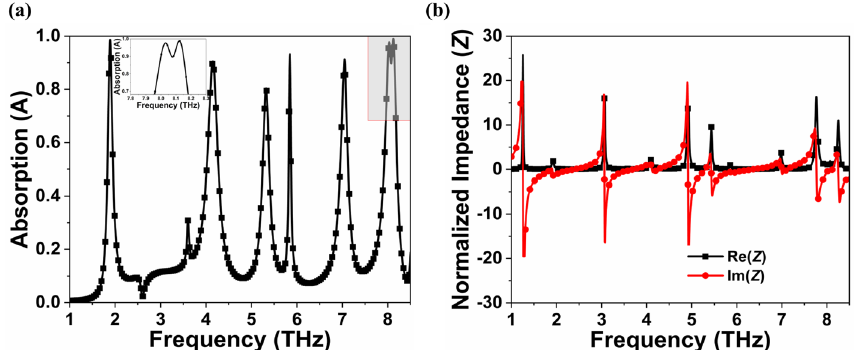
Figure 2. ( a ) Absorption spectra with its inset of f 6 and f 7 resonating frequencies and ( b ) Real and imaginary normalized impedance of the proposed